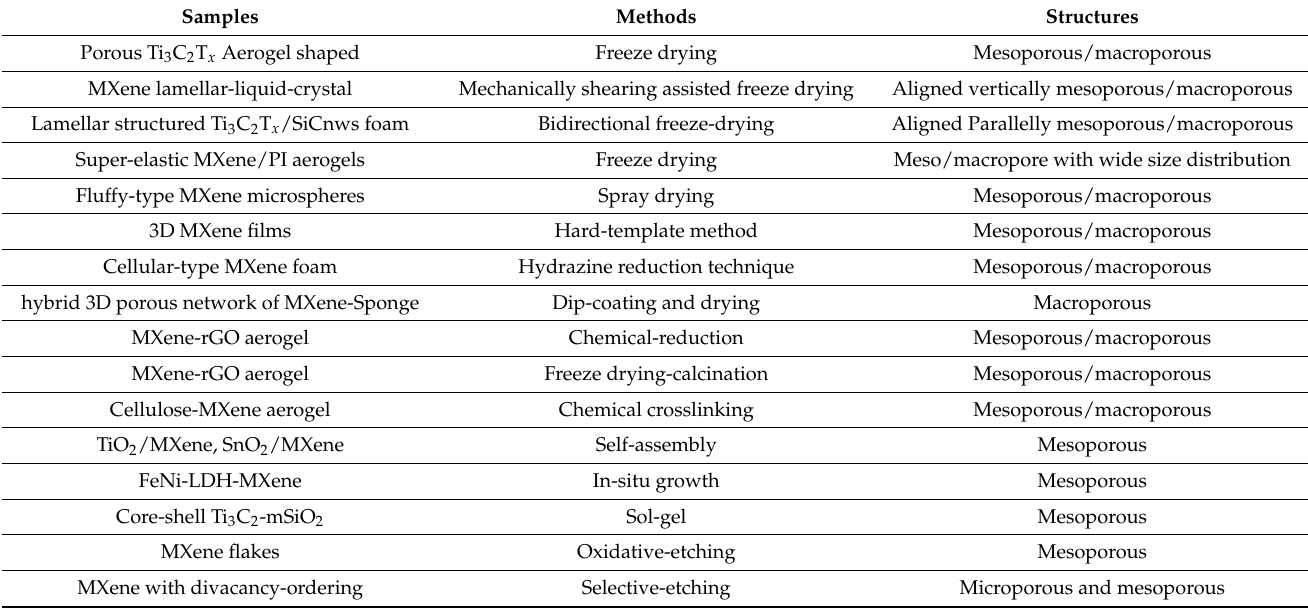
Table 1. Porous MXenes, synthesis methods, and their structures